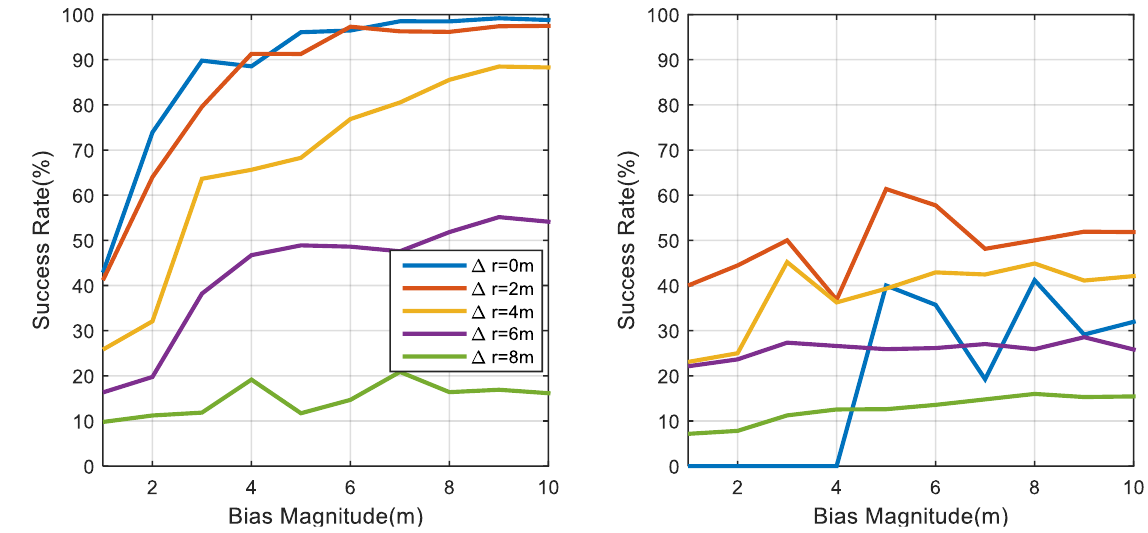
Figure 8. Compare of the success rate with different NLOS bias and initial coordinates for the MC algorithm ( Left ) and the ML method ( Right ).